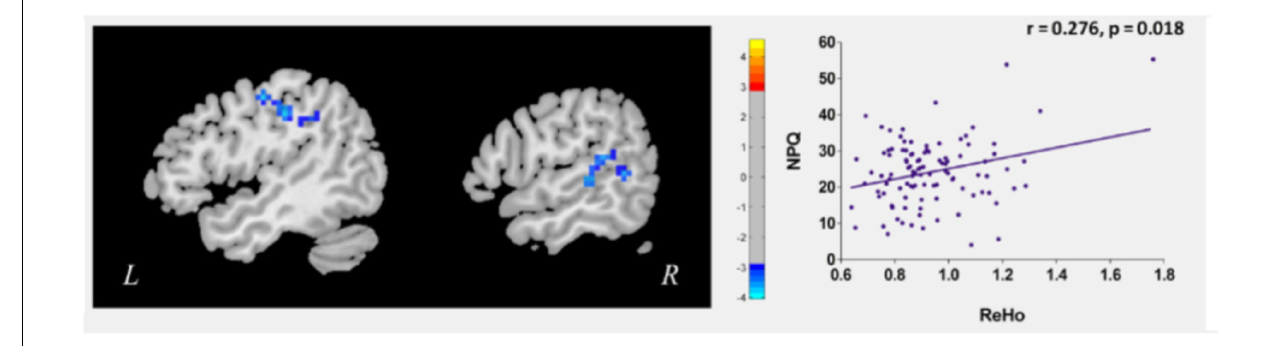
FIGURE 1 | Altered resting state ReHo in CSNP patients and the modulation effect of clinical treament. The left sensorimotor cortex and rTPJ showed reduced rs-ReHo in CSNP patients compared to healthy controls. The rs-ReHo value in rTPJ was associated with neck pain intensity (NPQ) at baseline in CSNP patients.